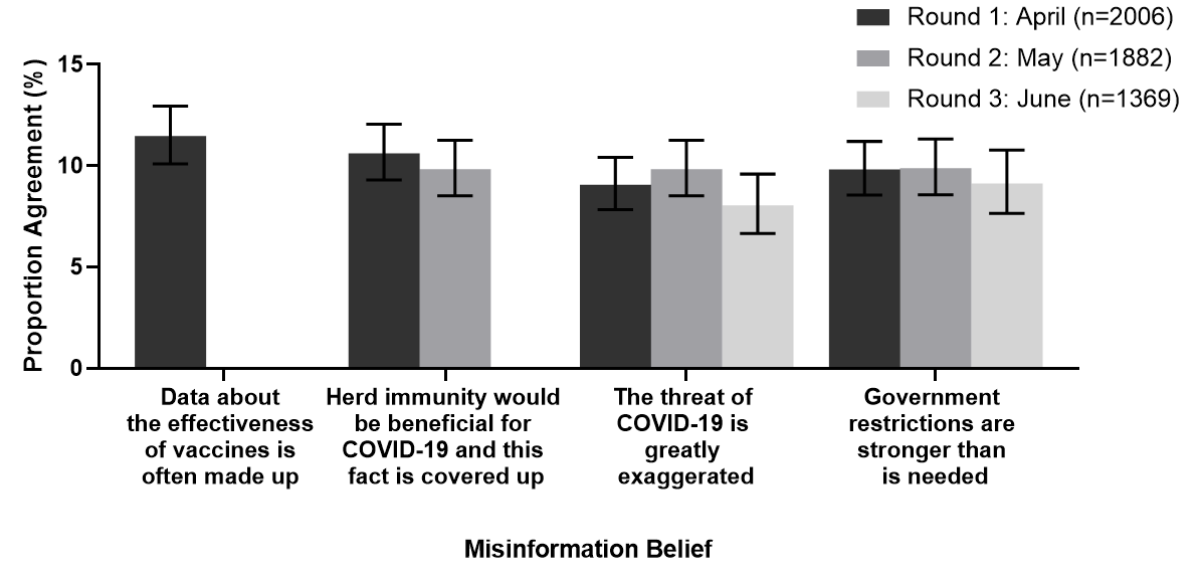
Table 4. Estimated means (95% CIs) of fixed effects from linear mixed models analyses (with random intercepts by the participant) of agreement with misinformation beliefs by study month and estimated mean differences (95% CIs) for pairwise comparisons to Round 1 (April).